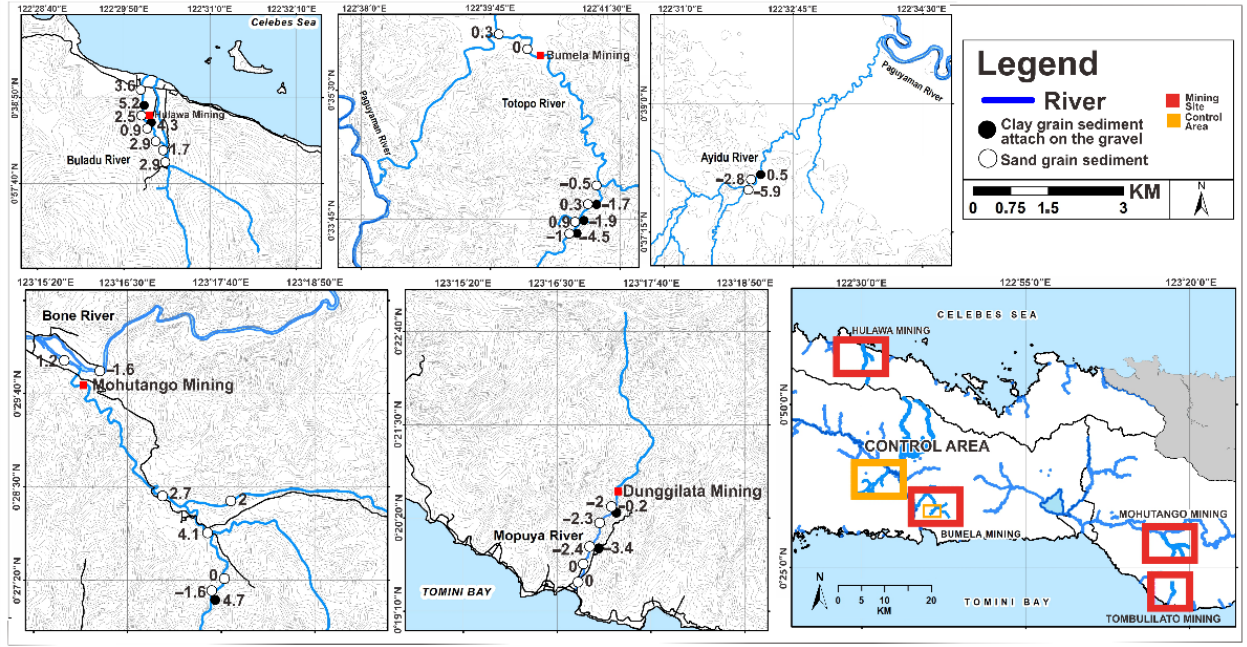
Figure 3. Plots of I geo and contaminant levels in As along the river sediments in Gorontalo Province, Indonesia (µg/g).